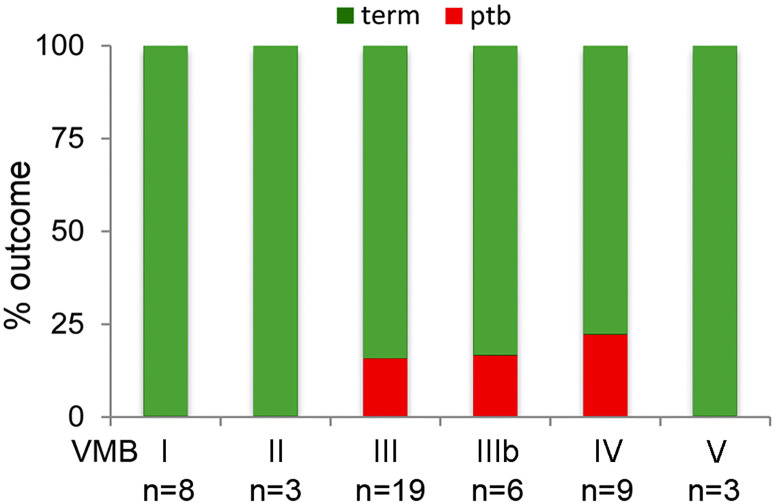
Delivery outcomes by VMB group in PWLWH. In those PWLWH where delivery outcome were available (n = 46/53), 16% (3/19) of women in VMB III delivered preterm, 17% (1/6) of women in VMB IIIb and 22% (2/9) of women in VMB IV. No preterm births were recorded in those women with VMB I, II, and V.